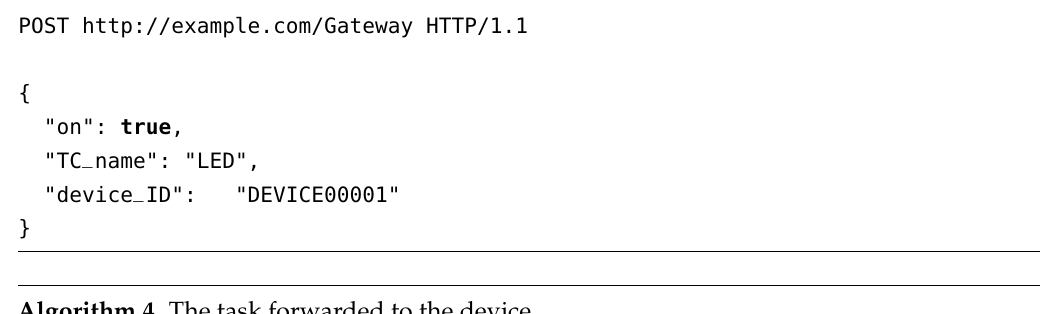
Algorithm 4. The task forwarded to the